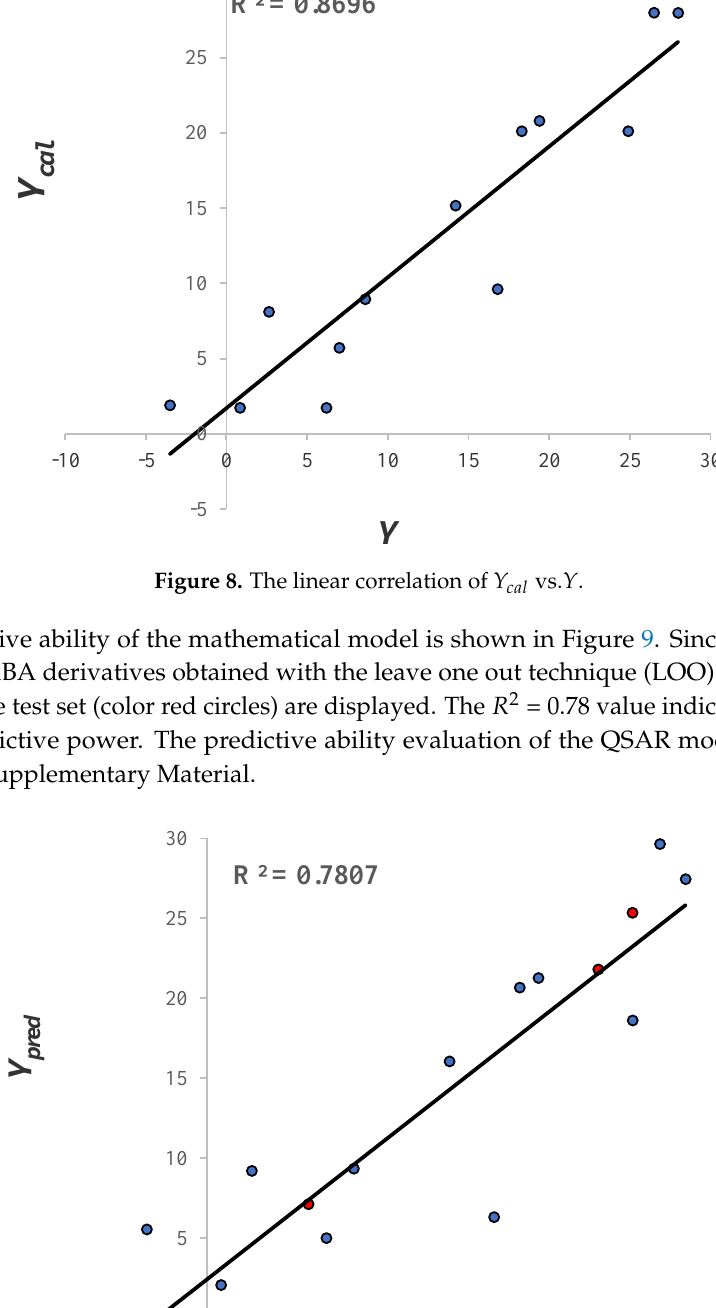
Figure 9. The linear correlation of Y pred vs. Y . Blue and red colored circles represent the training and test molecules, respectively.